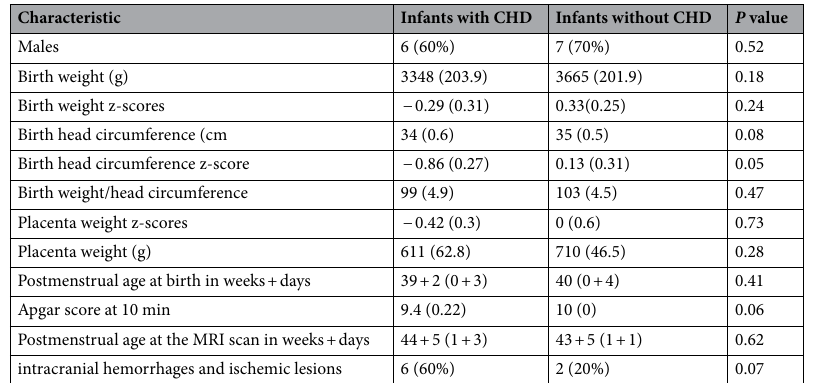
Table 1. Characteristics of the infants with CHDs and the infants without CHDs. In the “Males” row, the number of males in each group is shown (percentage). In the other rows, the data are presented as means (standard error). Categorial variables were compared between the infants using the chi-squared test and the Mann–Whitney U test was used for continuous variables. Grams (g), centimeters (cm), magnetic resonance imaging